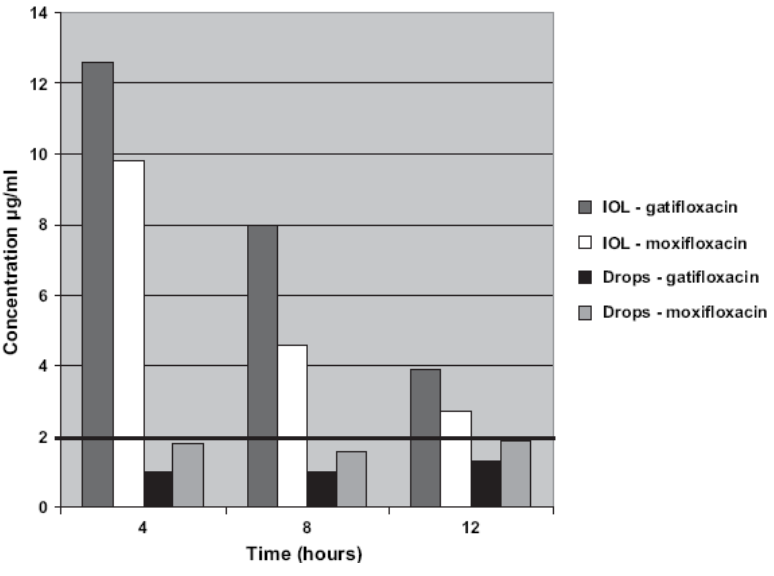
Figure 2. Gatifloxacin and moxifloxacin concentration in rabbits aqueous humor after implantation of drug-soaked IOLs or topical postoperative administration of drops to eyes that underwent non-soaked IOL implantation. In both groups, there was no statistically significant difference between the concentrations of the two antibiotics. Reproduced from reference [35] with permission of